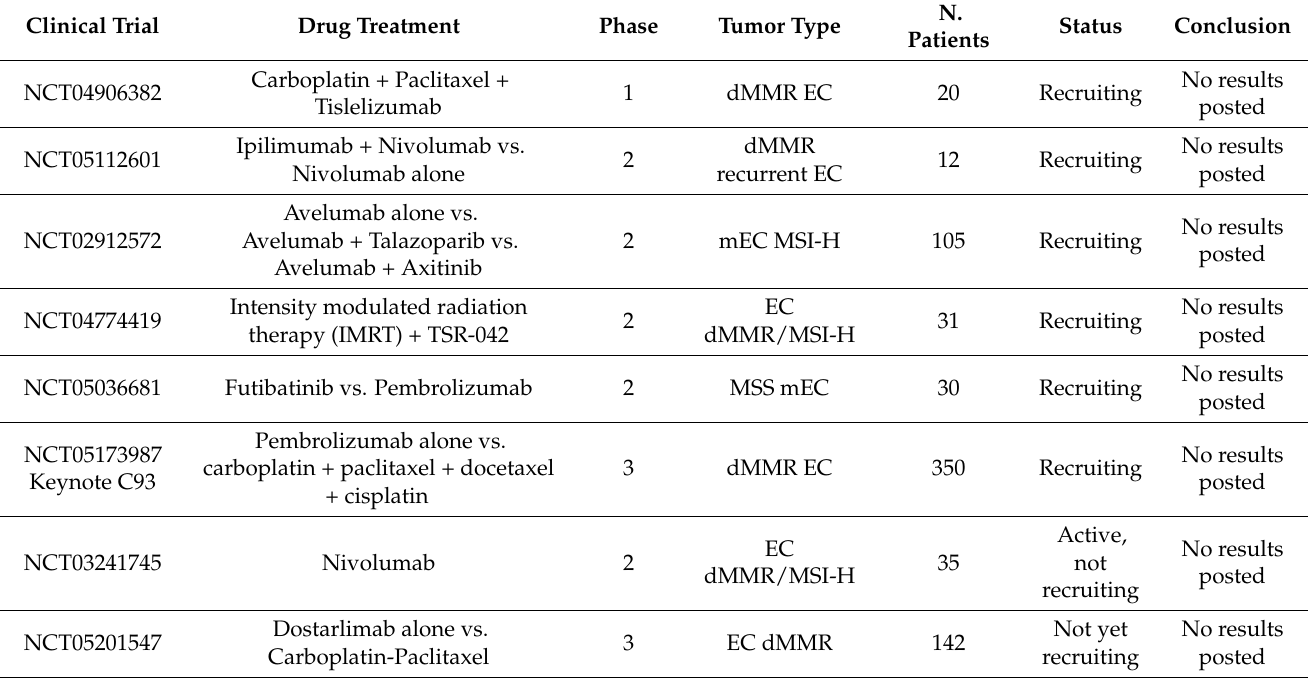
Table 7. Clinical trials for immune checkpoint inhibitors treatment of MSI EC.